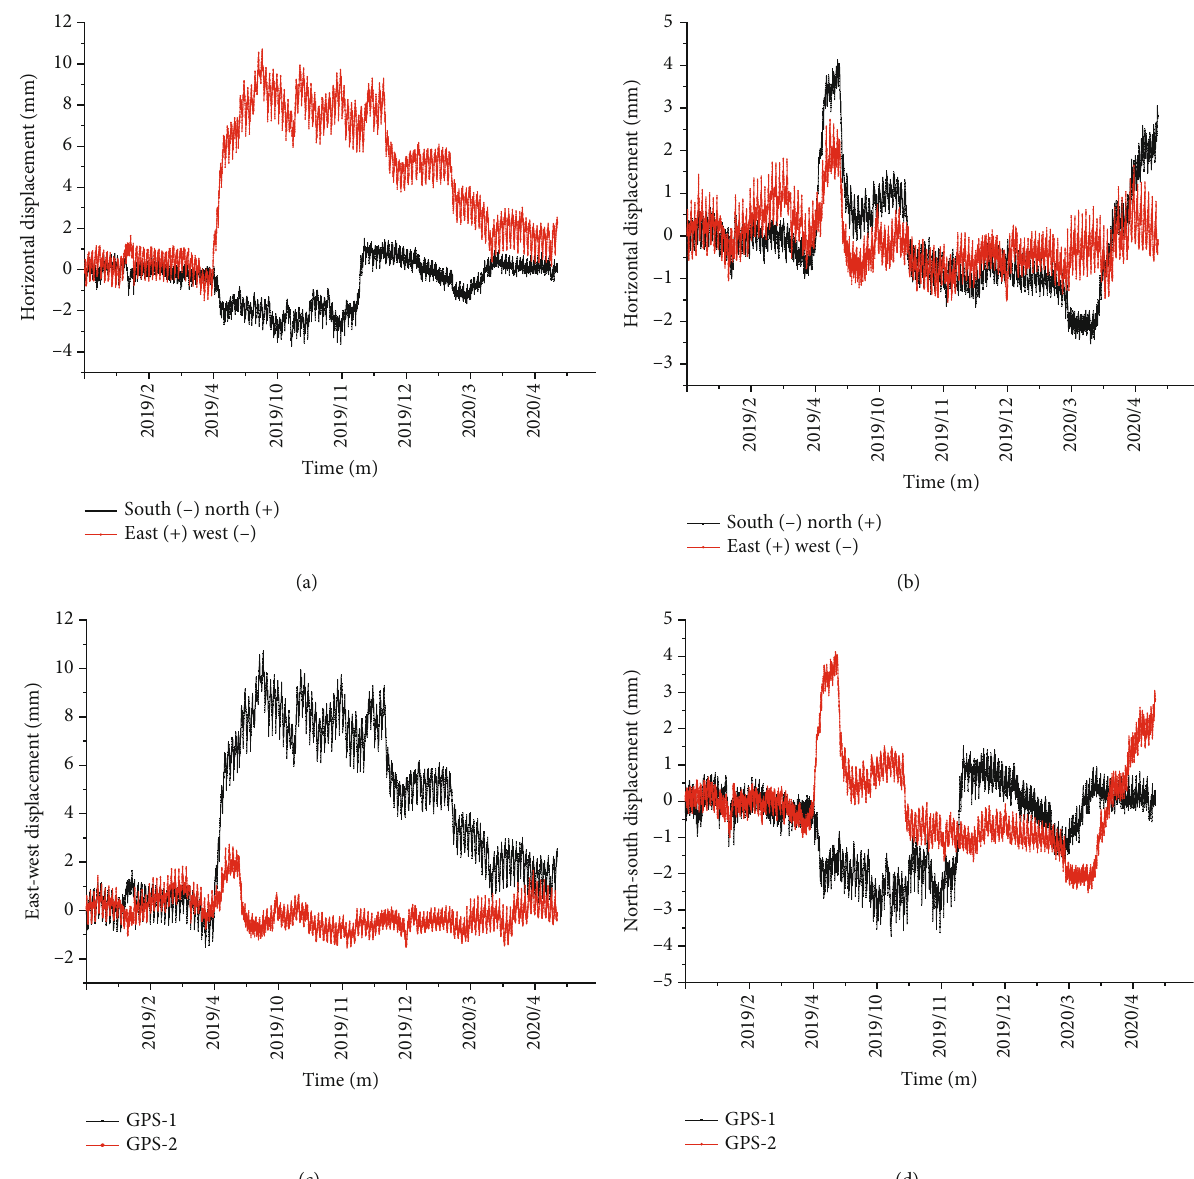
Figure 8: In situ monitoring data: (a) horizontal displacement of the GPS-1 displacement monitoring point; (b) horizontal displacement of the GPS-2 displacement monitoring point; (c) comparison of east-west displacement of the GPS1/GPS2 monitoring point; (d) comparison of the north-south displacement of the GPS1/GPS2 monitoring